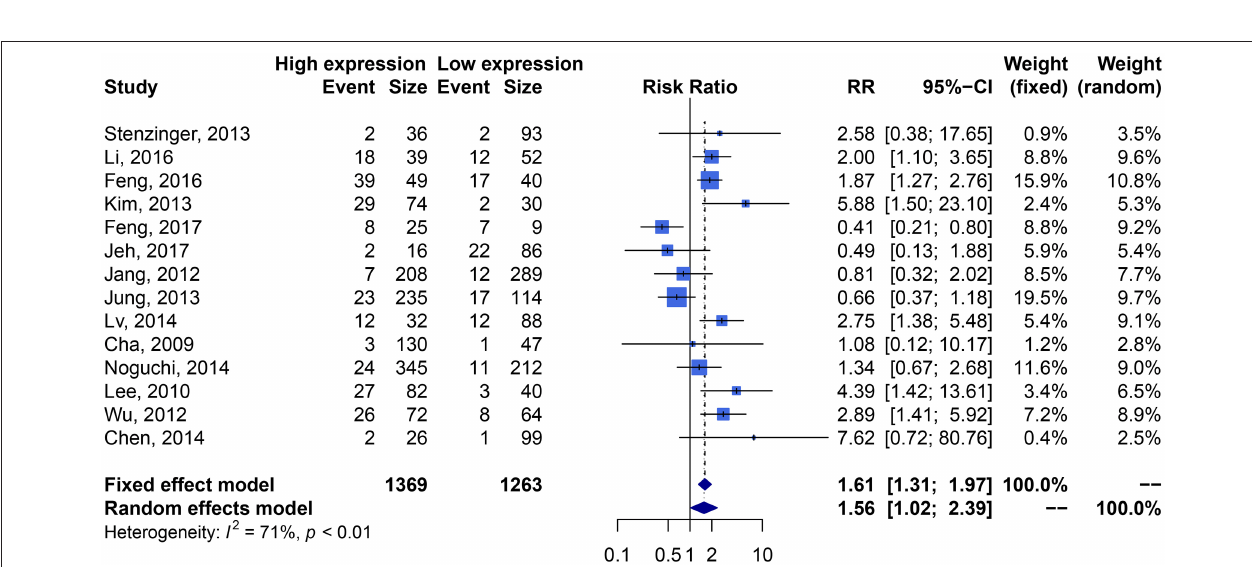
FIGURE 6 | Forest plots of distant metastasis compared SIRT1 overexpression with underexpression.